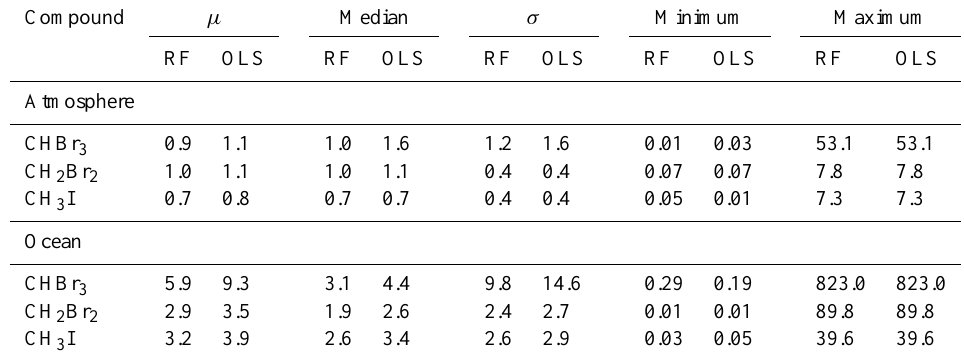
Table 1. Statistical moments: mean ( µ) , median, standard deviation ( σ) , minimum and maximum values of atmospheric mixing ratio (ppt) and oceanic concentration (pmolL − 1 ) climatologies of CHBr 3 , CH 2 Br 2 and CH 3 I based on the RF and OLS regression analyses.